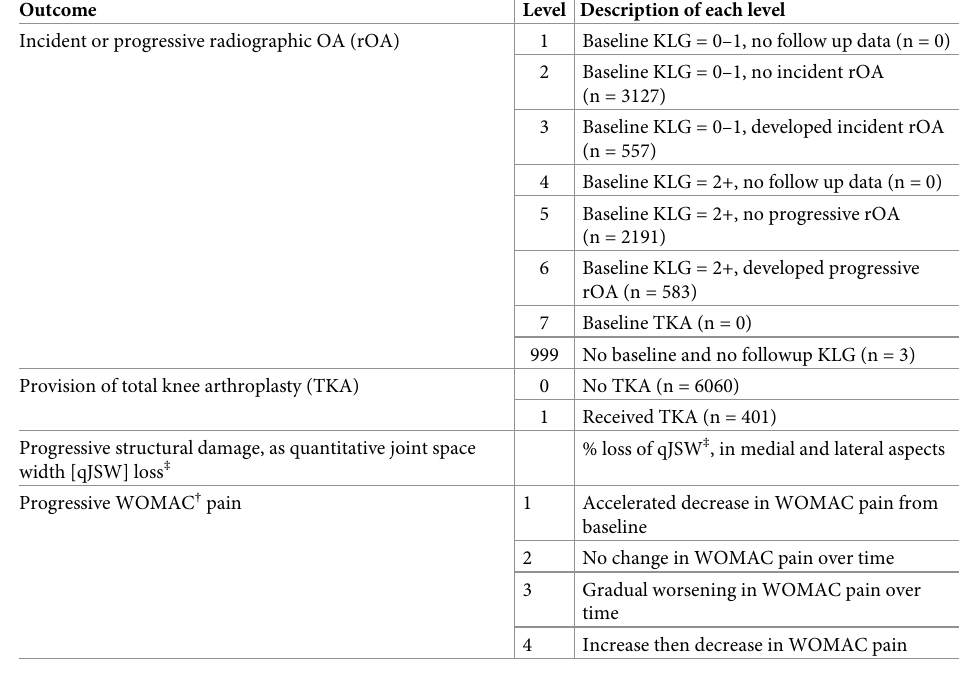
Table 1. Summary of outcomes over 96 months of follow-up in the OAI � .